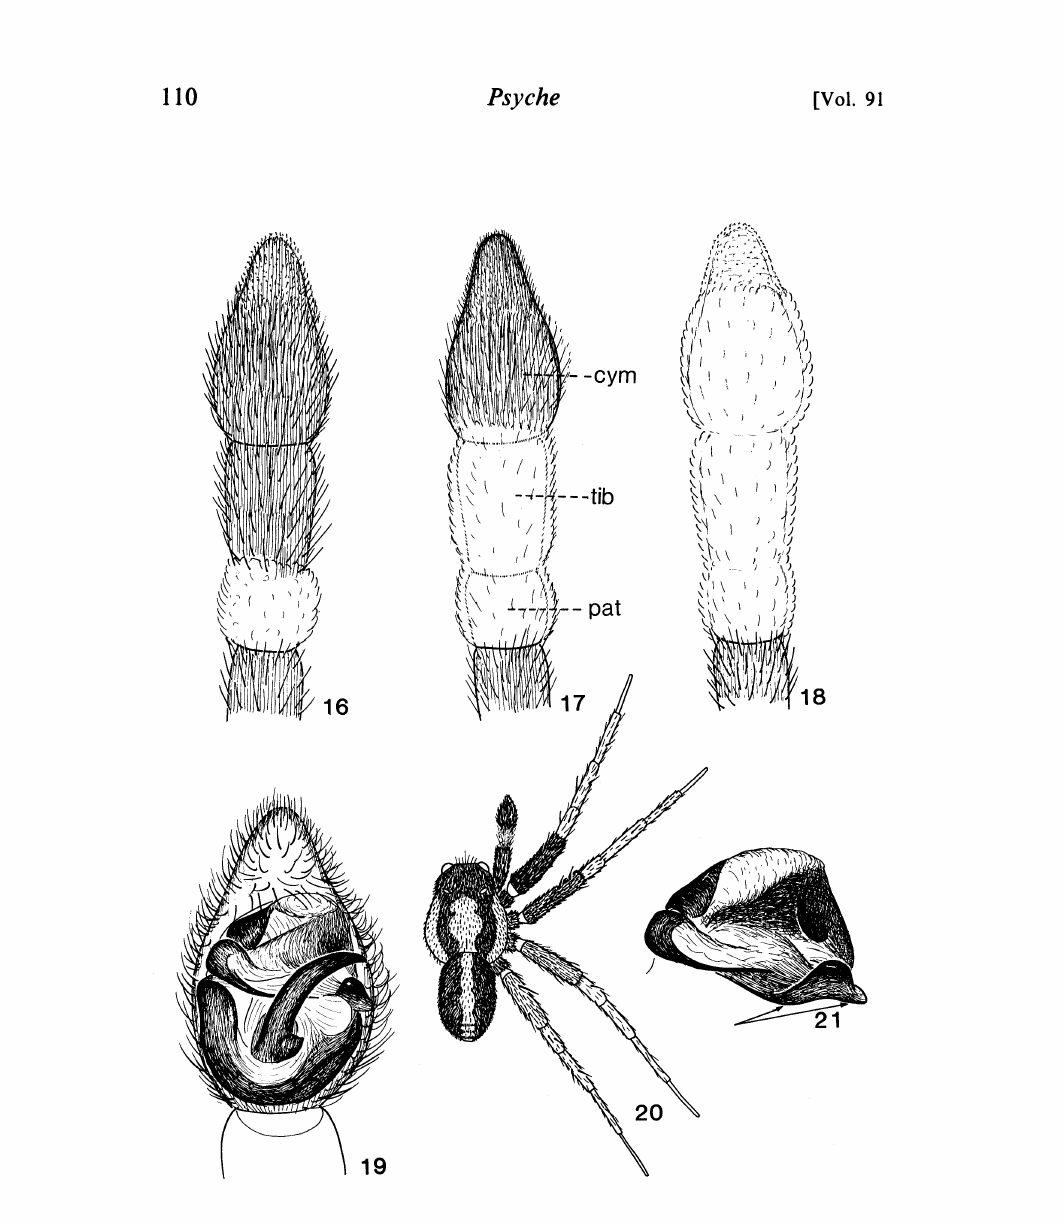
Figs. 16-21. Male structures of Pardosa spp. 16-18, palpus, dorsal view. 19, palpus, ventral view. 20, body, dorsal view. 21, apical division, ventral view. 16,19-21, P. saxatilis (Hentz). 17, P. atlantica Emerton. 18, P. parvula